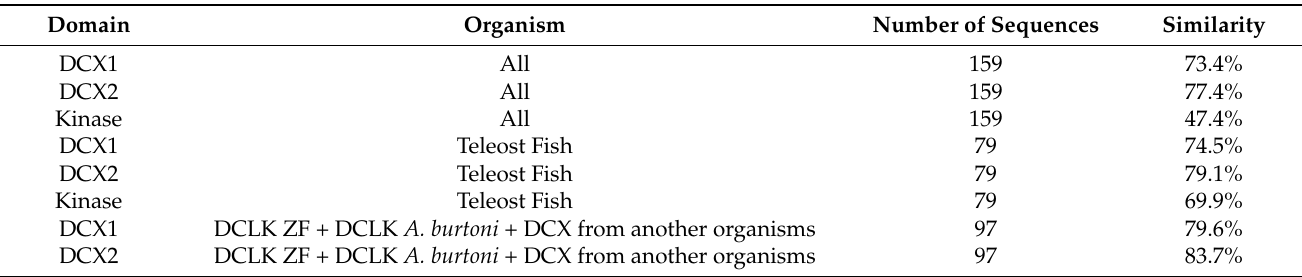
Table 3. Sequece similarities between DCX1 and DCX2 domains after its extraction from DCX and/or DCLK. Comparison of DCX1 and DCX2 conserved domains to analyze the identity between different species.